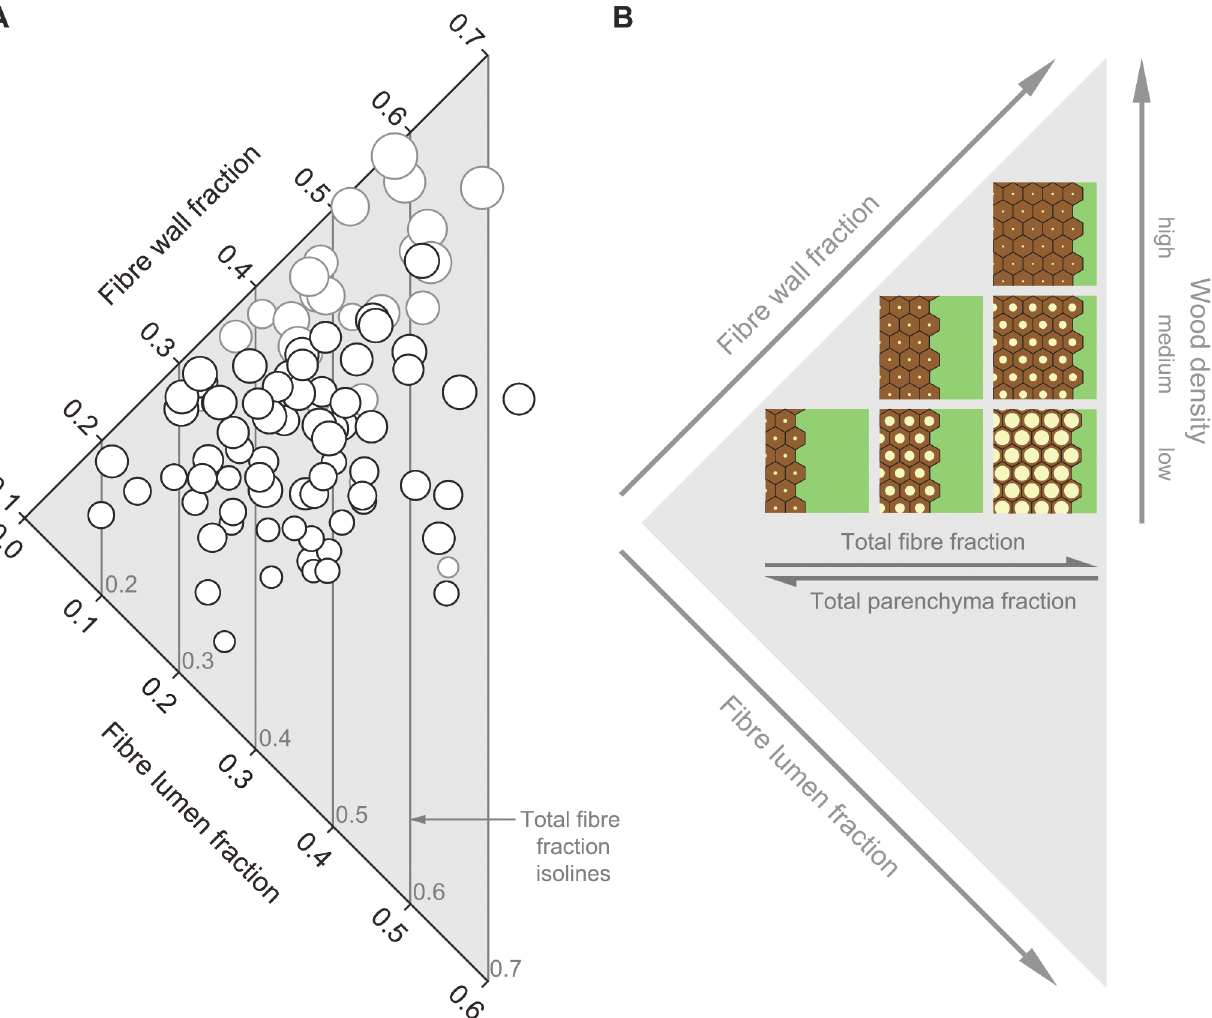
Fig 4. Relationship between fibre wall fraction and fibre lumen fraction across 93 species (A) and a diagram illustrating this relationship (B). (A) Black symbols represent 69 from this study and grey symbols represent 24 species from [12]. Symbol diameter is proportional to species wood density. With the smallest diameter corresponding to the lowest density and the largest diameter to the highest density. Isolines indicate total fibre fraction increasing from left to right by a step of 0.1. Grey numbers above the X axis correspond to total fibre fraction indicated by a given isoline. (B) A diagram illustrating Fig 4A; the diagram is modified from Fig 8 in [12]. The six squares symbolize cross-sections through six different woods. Hexagons are fibres with fibre wall in brown and fibre lumen in bright yellow. Green is parenchyma (axial + ray). Vessel fraction was relatively small, and did not show large variation across species, so for simplicity was omitted in this diagram. Wood density increases towards the top of the diagram. Total fibre fraction (brown wall + yellow lumen) and total parenchyma fraction (green, includes axial + ray) covary negatively with each other and approximately orthogonally to wood